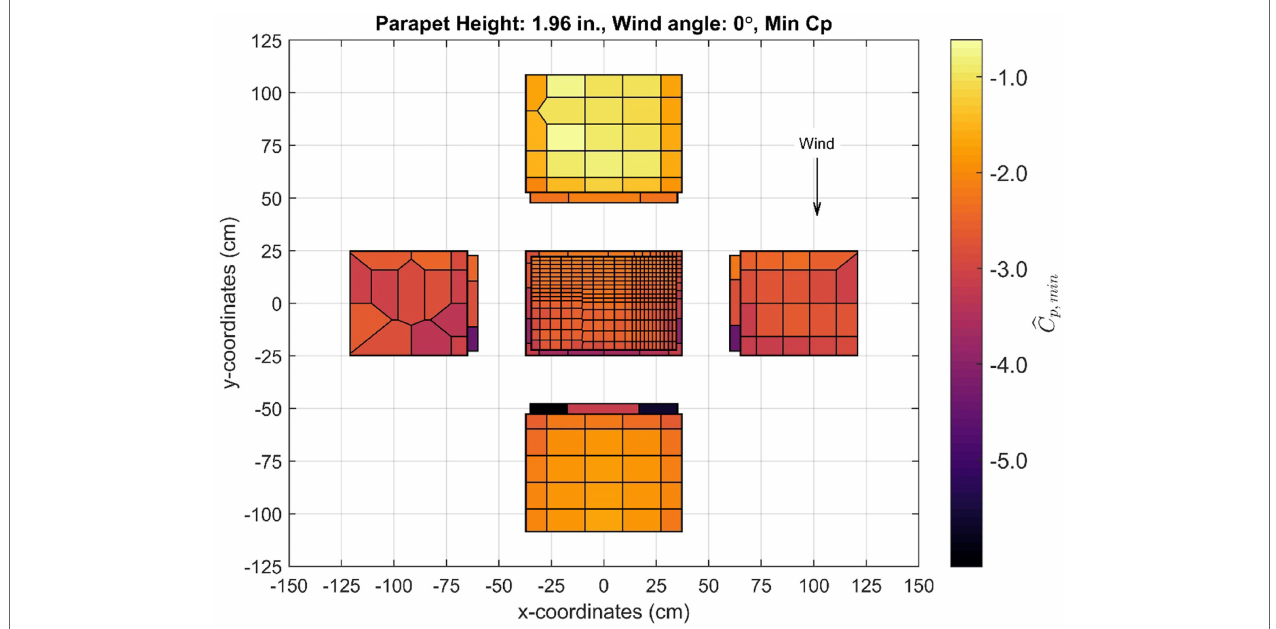
FIGURE 13 | Minimum pressure coefficients for optimal parapet height, 0° wind angle shown.